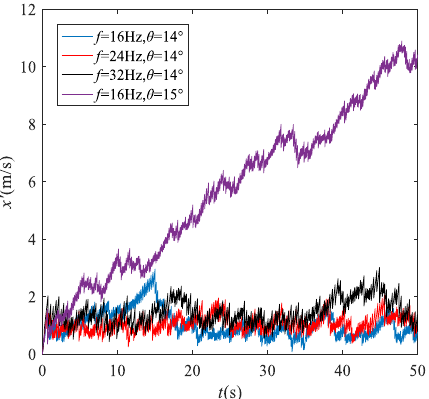
Figure 9. Particle speed in 50 s at A = 5 mm, θ = 14, 15°, a = 90°, and f = 16, 24, 32 Hz.